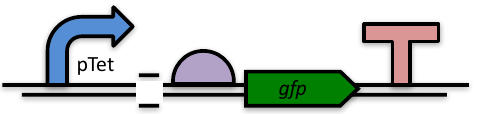
Figure 28: The same functional unit as in the previous figure, with additional assembly-focused information: there is a 5’ overhang before the promoter, a 3’ overhand after the terminator, and an assembly scar between the promoter and the ribosome entry site left over from a prior step of assembly.